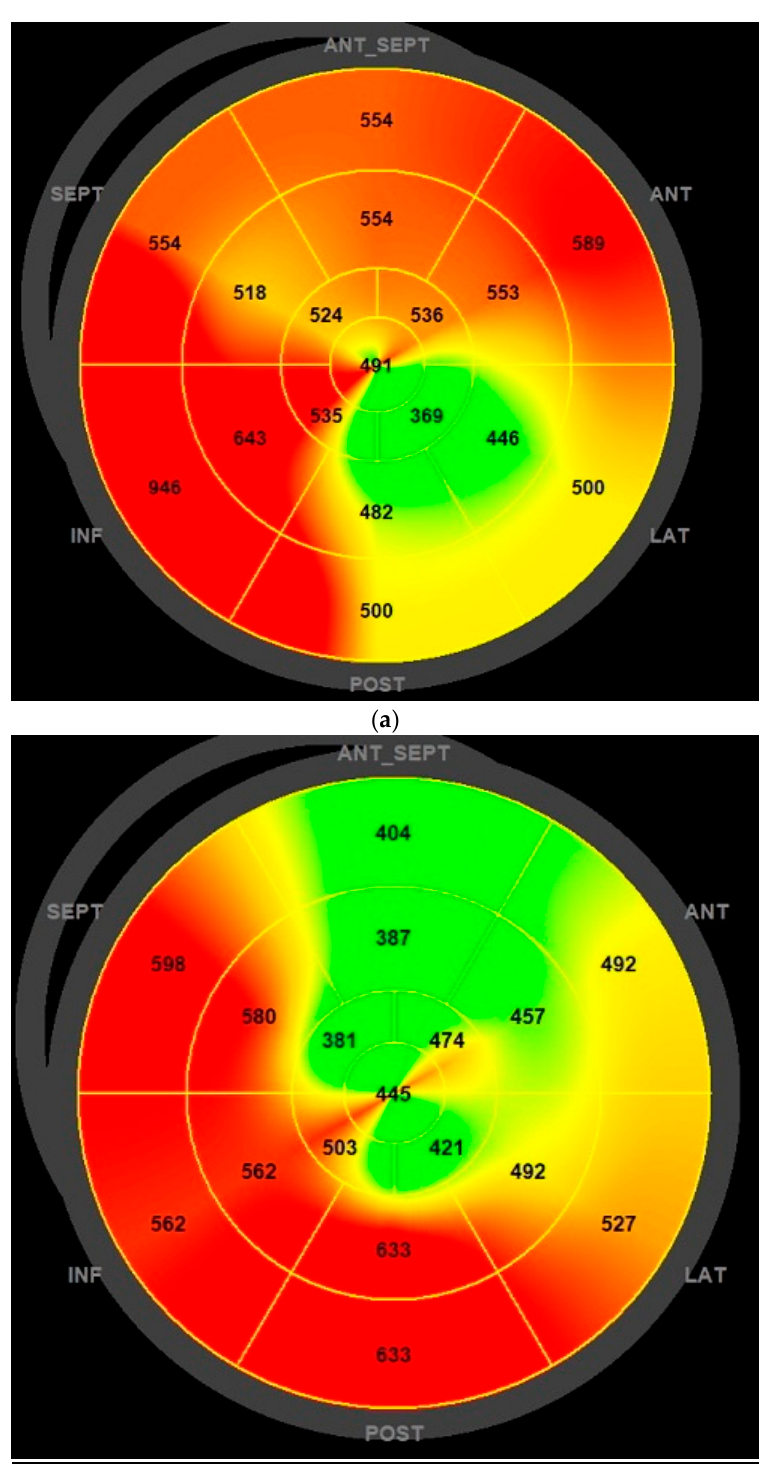
Figure 2. Mechanical dispersion bullseye plot reduction before ( a ) and after ( b ) six months of LCZ696 therapy.